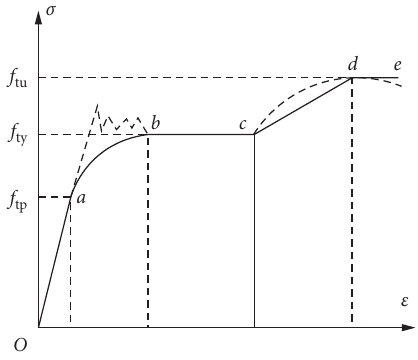
Figure 2: Stress-strain curve of steel.